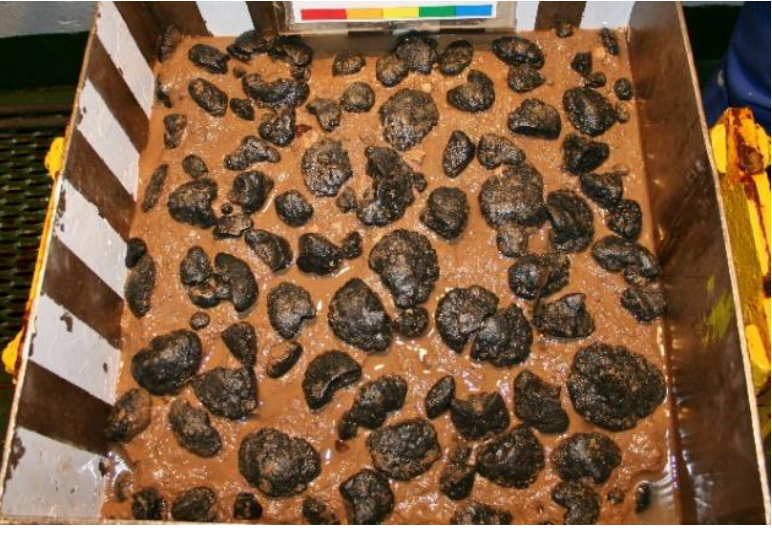
Figure 3. Polymetallic nodule sample collected during exploration, source: IOM, photo taken by T. Abramowski.